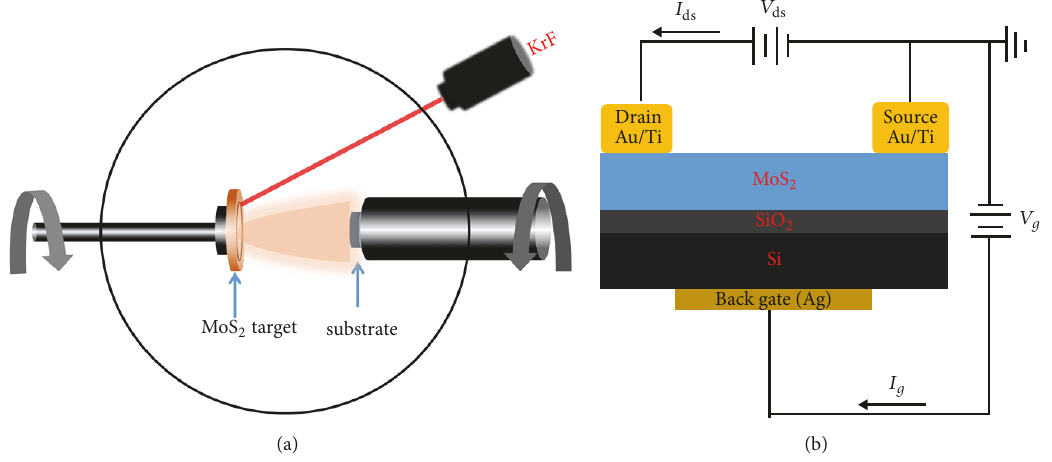
Figure 1: Schematic diagram of (a) PLD equipment; (b) MoS 2 back-gated FETs